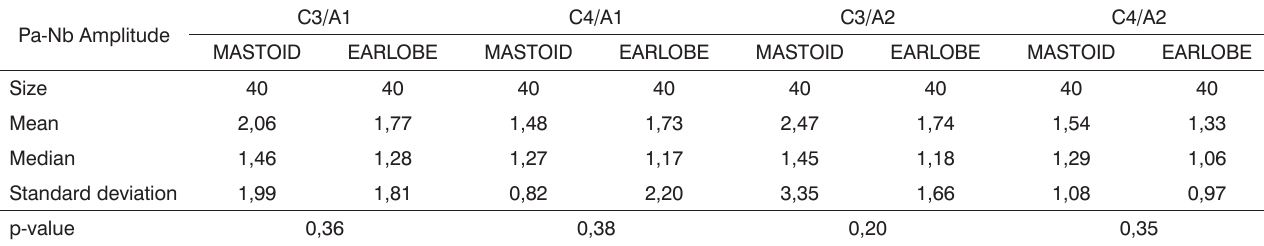
Table 2. Comparing Pa-Nb amplitudes in MLEAP C3/A1, C4/A1, C3/A2, C4/A2 modes, between the mastoid and earlobe.